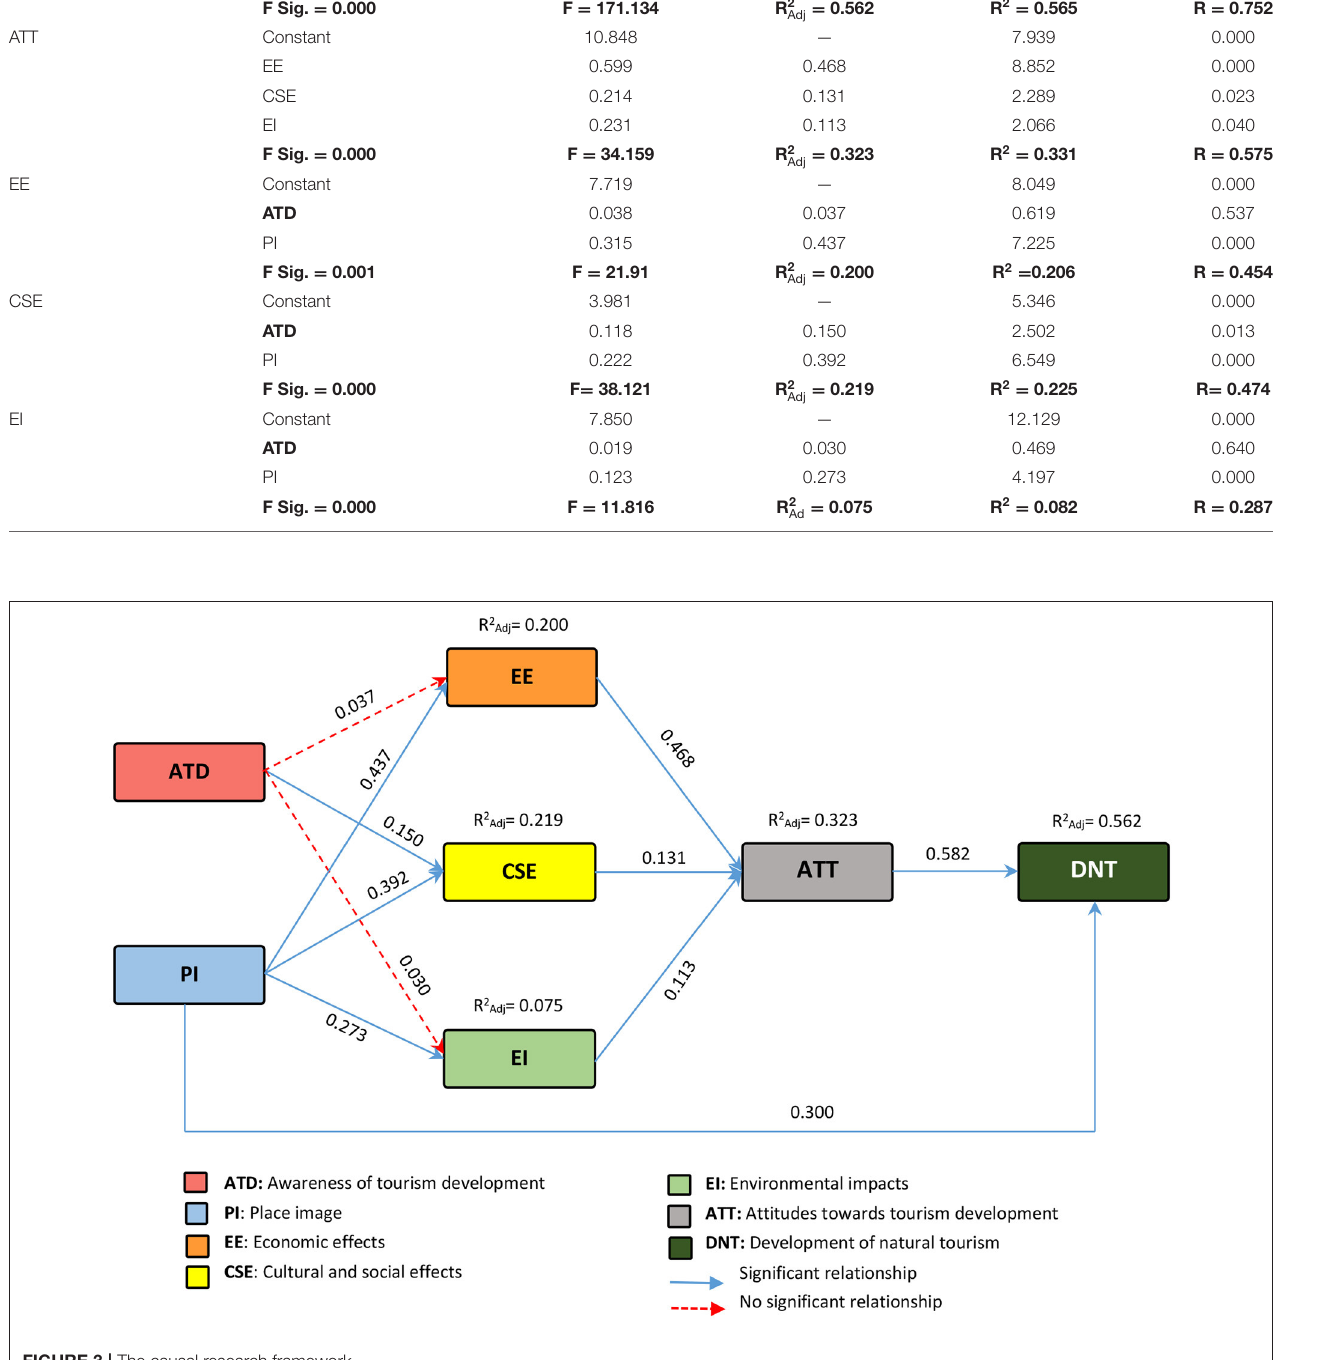
FIGURE 3 | The causal research